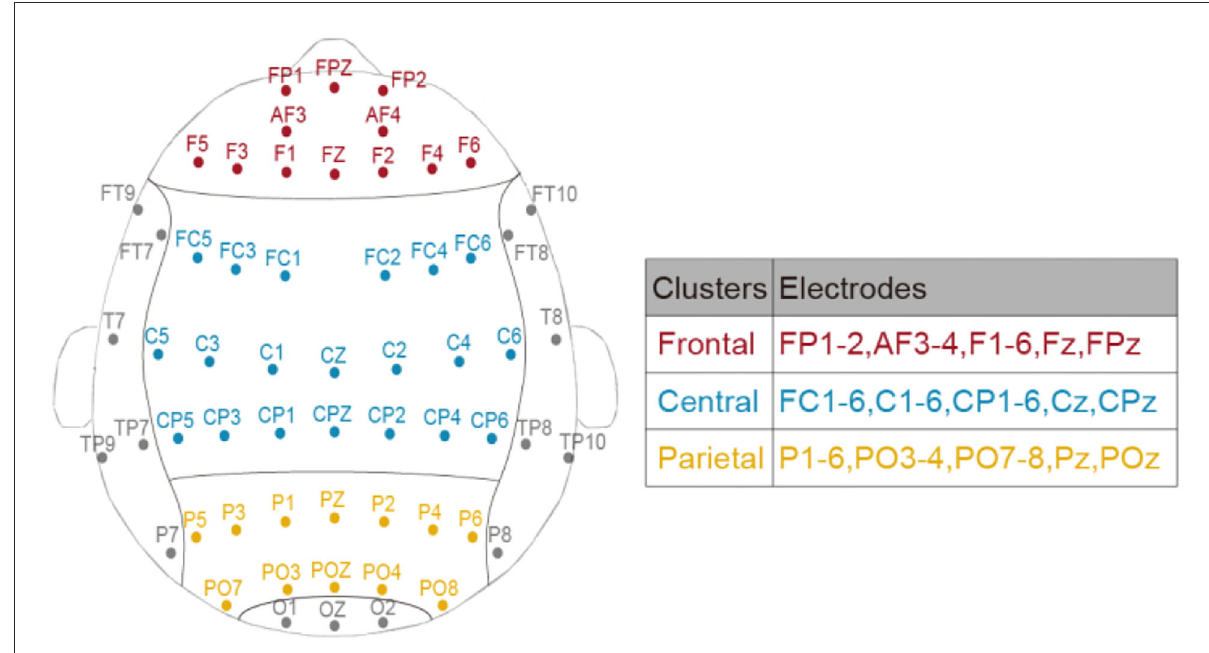
FIGURE2 The assignment of electrodes in frontal, central, and parietal